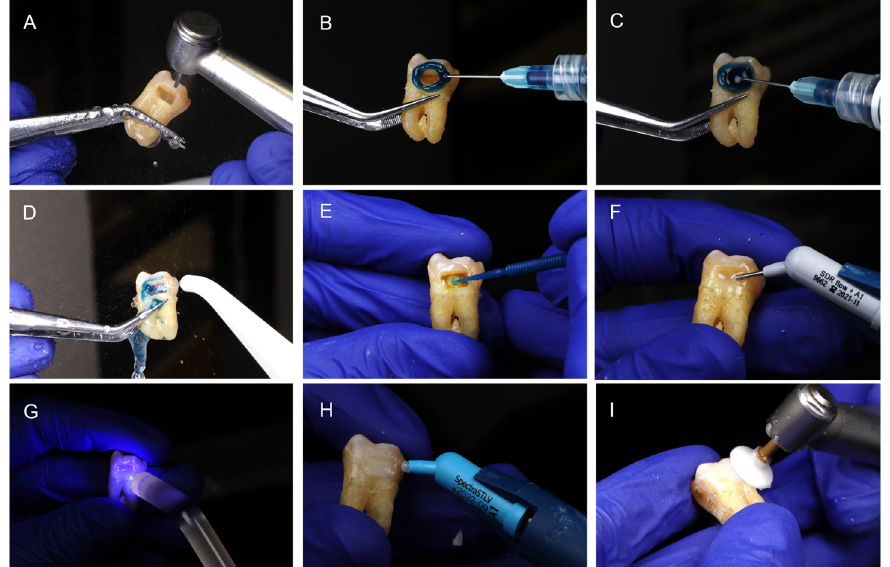
Figure 1. ( A ) Preparation of the cavity of standard dimensions on the buccal face of one of the samples. ( B ) Acid etching of enamel with 35% orthophosphoric acid for 30 s. ( C ) Acid etching of dentin with 35% orthophosphoric acid for 15 s. ( D ) Washing with air/water jet for 30 s. ( E ) Placement of Prime & Bond Universal adhesive system throughout the prepared cavity. ( F ) Placement of a 2 mm increment of SDR ®® flow+ resin under the adhesive layer. ( G ) Light curing of the SDR ®® flow+ resin layer. ( H ) Final 1 mm increment placement of Spectra ST HV resin. ( I ) Polishing of the restoration.